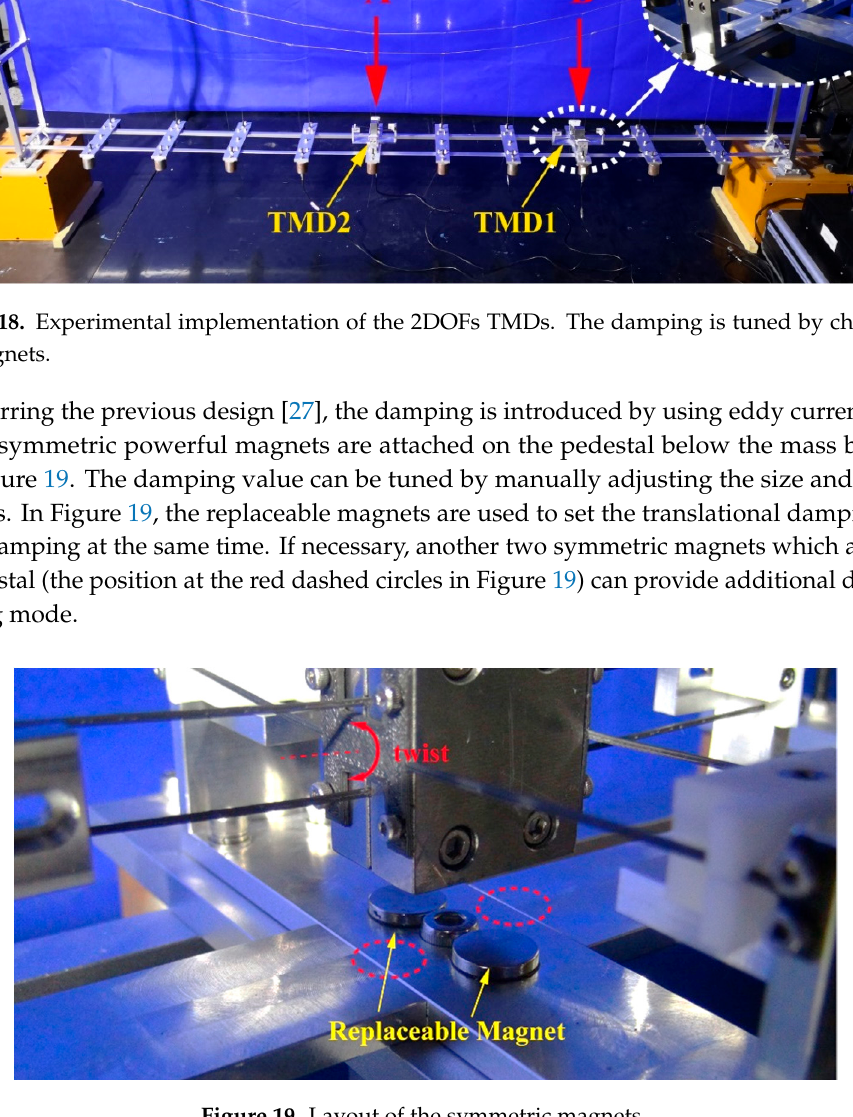
Figure 17. Experimental acceleration responses of the designed TMDs. ( a ) TMD1; ( b ) TMD2.